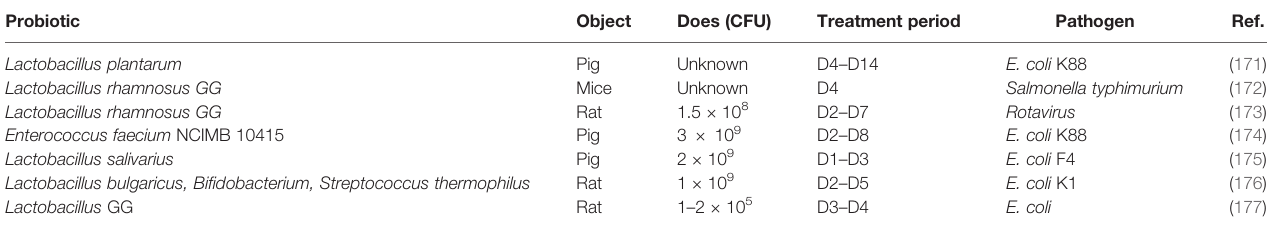
TABLE 2 | The effect of probiotics on intestinal pathogen infection.